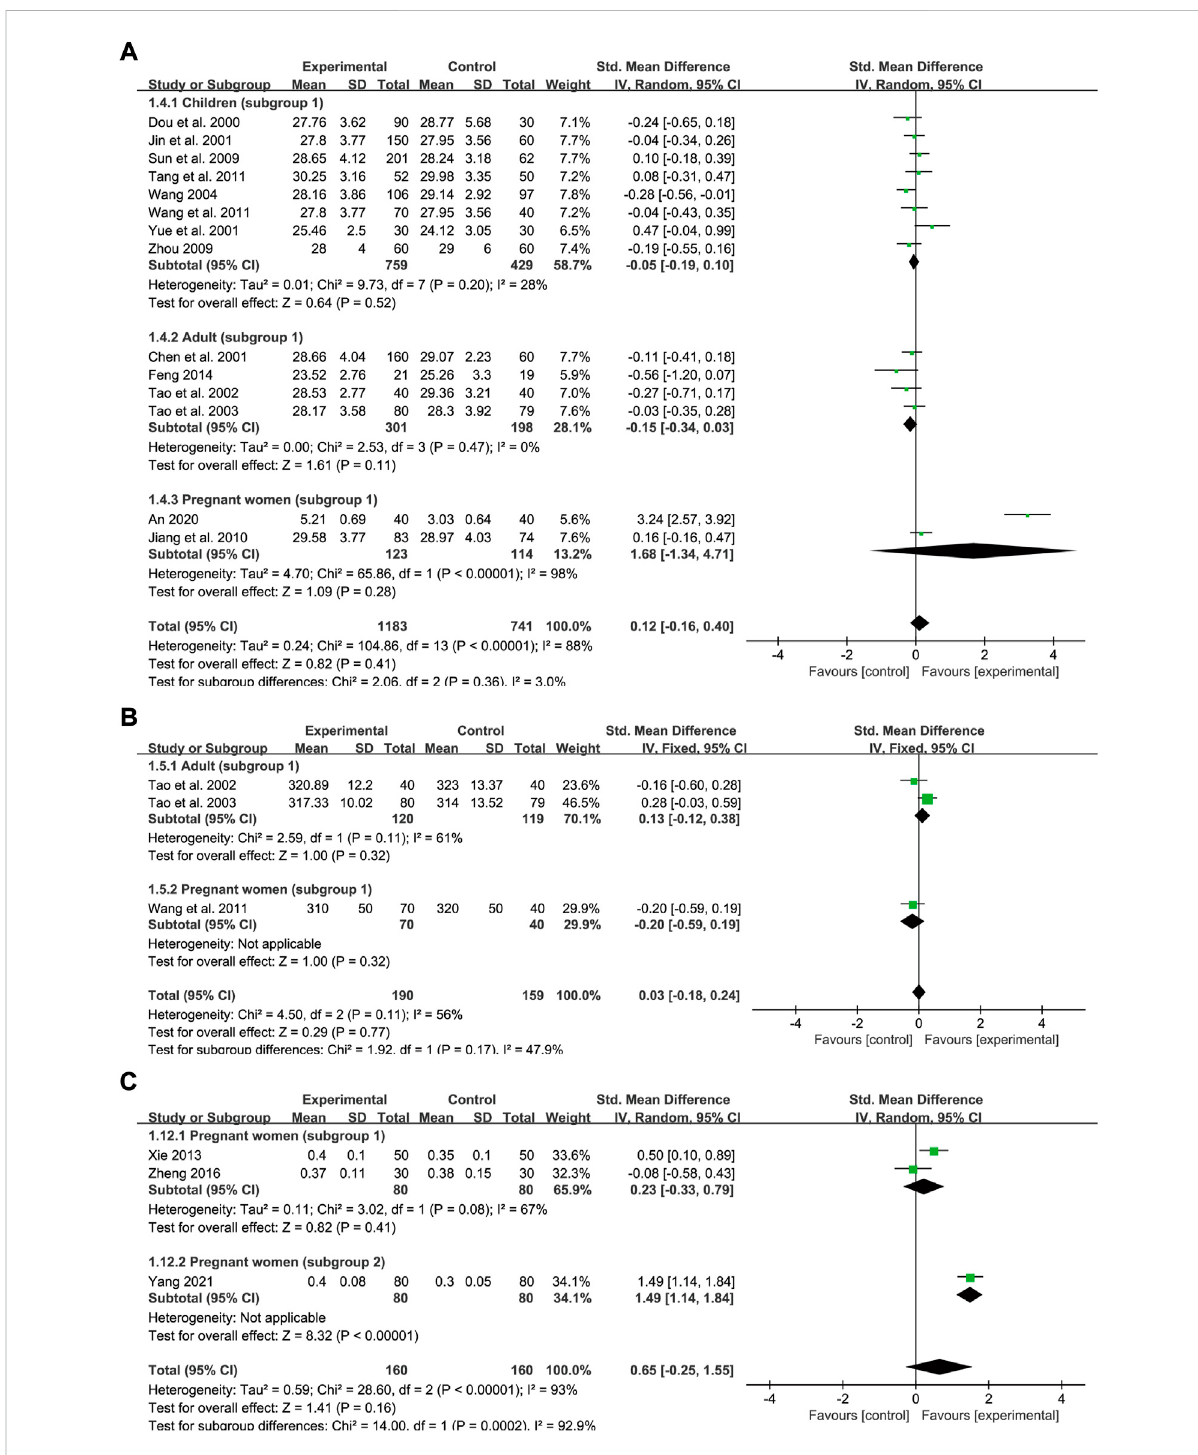
FIGURE 6 The forest plot assessing the effect of SXN on MCH (A) , MCHC (B) , and HCT (C)